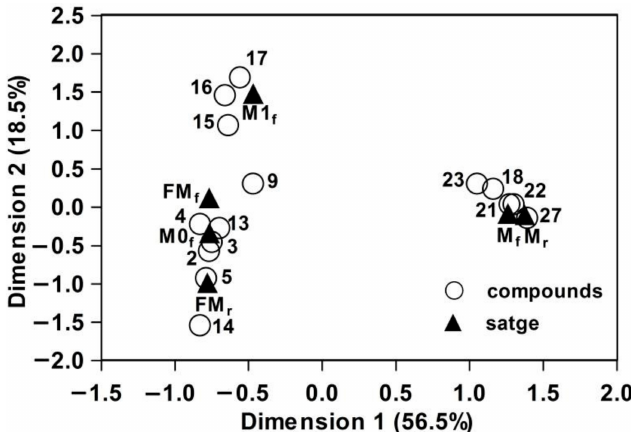
Figure 4. Score plots from correspondence analysis (CA) of floral scents in male and female flowers of the two Breynia species